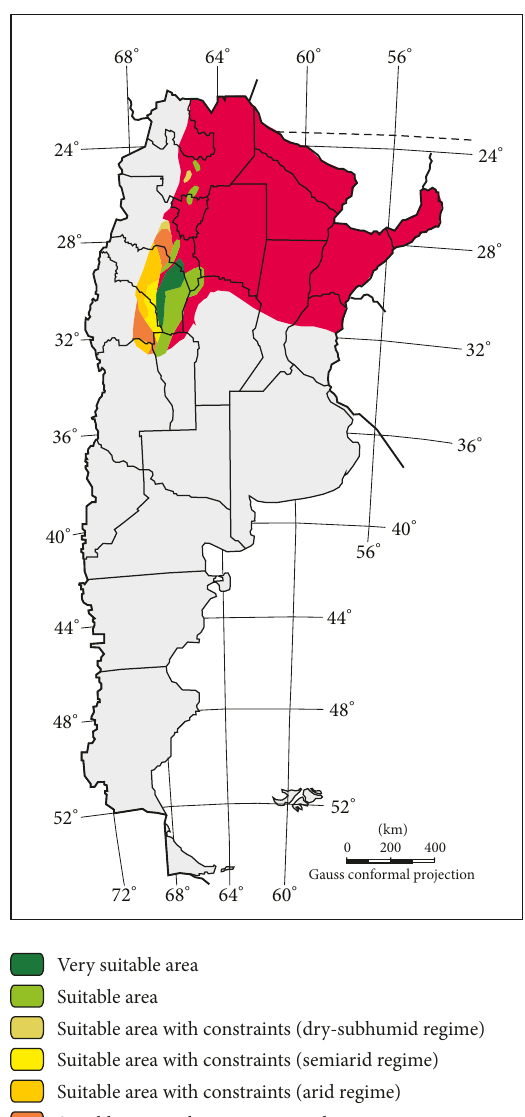
Figure 9: Agroclimatic zoning for the argan tree.